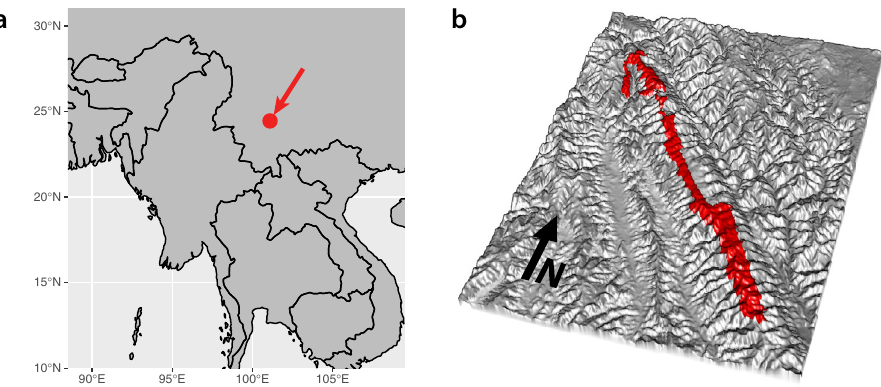
Fig. 1 Study site location and layout. a The Ailaoshan reserve is located in Yunnan Province, southwest China. Map shows location of reserve with red arrow. b The Ailaoshan reserve runs northwest-to-southeast along a ridgeline for ~125 km, but averages just 6 km across along its entire length. Three- dimensional rendering shows reserve with red